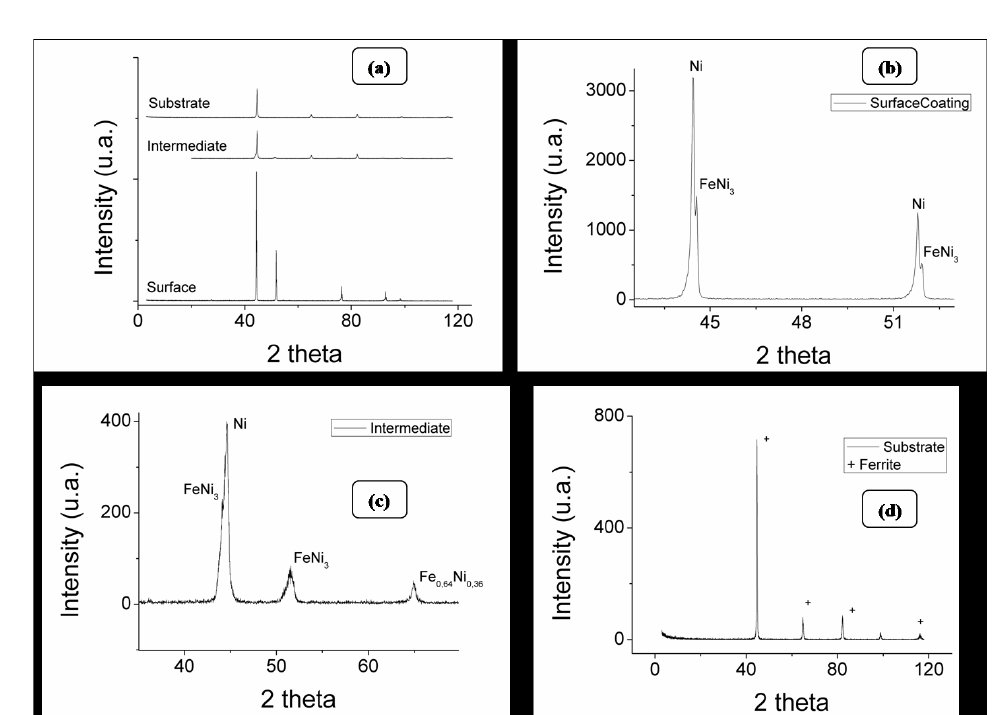
Figure 7: X-Ray diffraction. (a) Whole sample; (b) Surface coating; (c) Second layer; and (d)